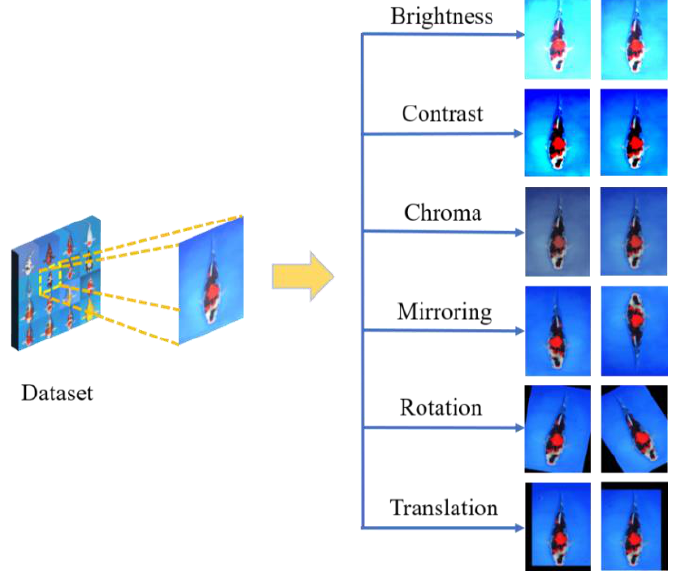
Figure 2. Effect of data augmentation.